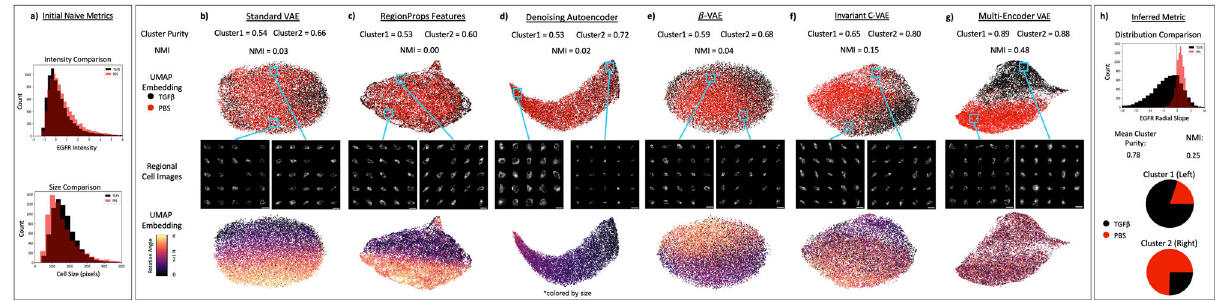
Fig. 2 Separation of biologically distinct cell populations. a Cells are compared using initial naive metrics such as mean EGFR intensity and cell size to show the dif fi culty separating the cell populations. b – g The model architectures are quantitatively evaluated using cluster purity and normalized mutual information ( k -means with the number of clusters = 2). The sample size for all comparison methods and metrics is n = 15,898 single-cell images. A qualitative comparison is made using visual separation of two labeled cell populations in UMAP embedding space and visual analysis of cells from UMAP regions to identify biologically distinct factors. Rotation angles of cells are shown in UMAP embedding to show the in fl uence of unimportant features on downstream analysis. h The same population of cells is compared using radial slope (a metric inferred from visually analyzing the regional cell images in g ). Scale bars in b – g represent 20 μ